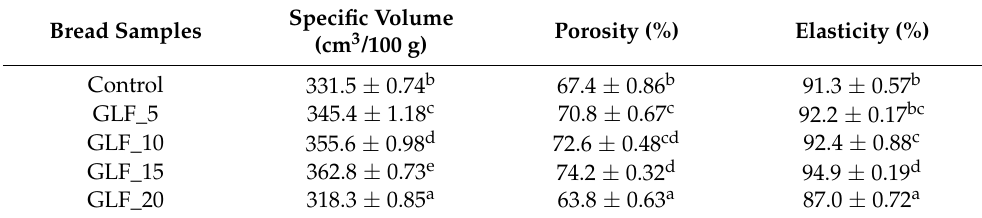
Table 4. Physical characteristics of the bread samples with different levels of GLF additions. Bread Samples